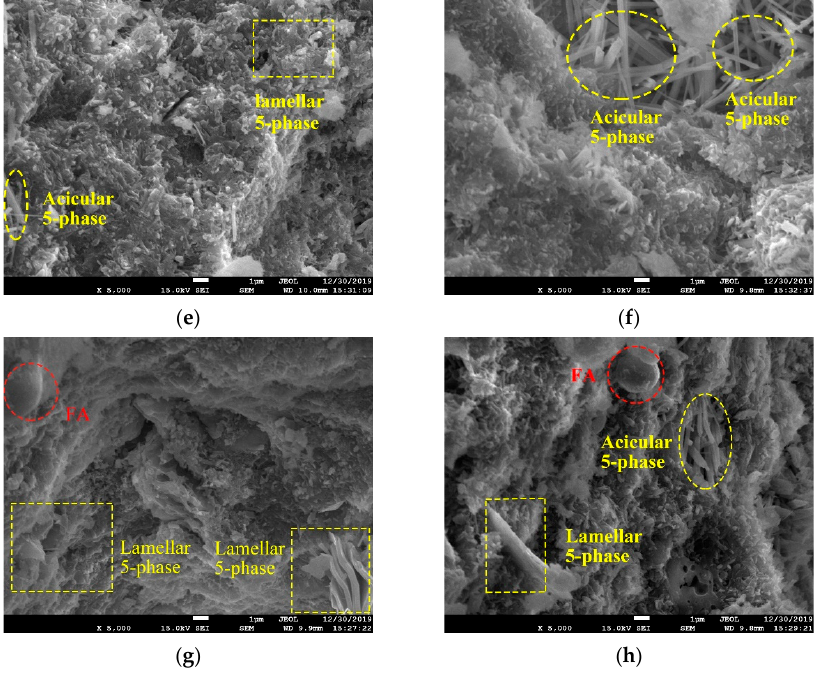
Figure 14. SEM observations of blended MOC samples ( a ) Group B1, ( b ) Group B4, ( c ) Group C1, ( d ) Group C4, ( e ) Group D1, ( f ) Group D4, ( g ) Group E1 and ( h ) Group E4.